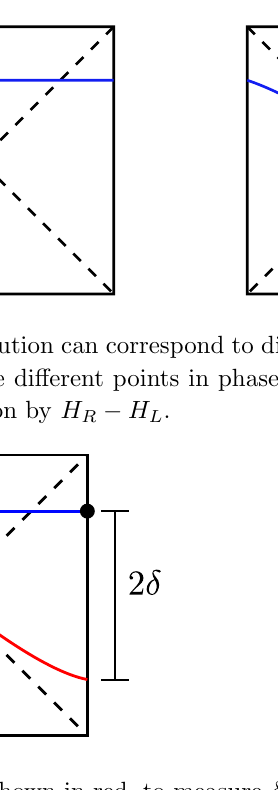
Figure 4 . Using a geodesic, shown in red, to measure (cid:14)